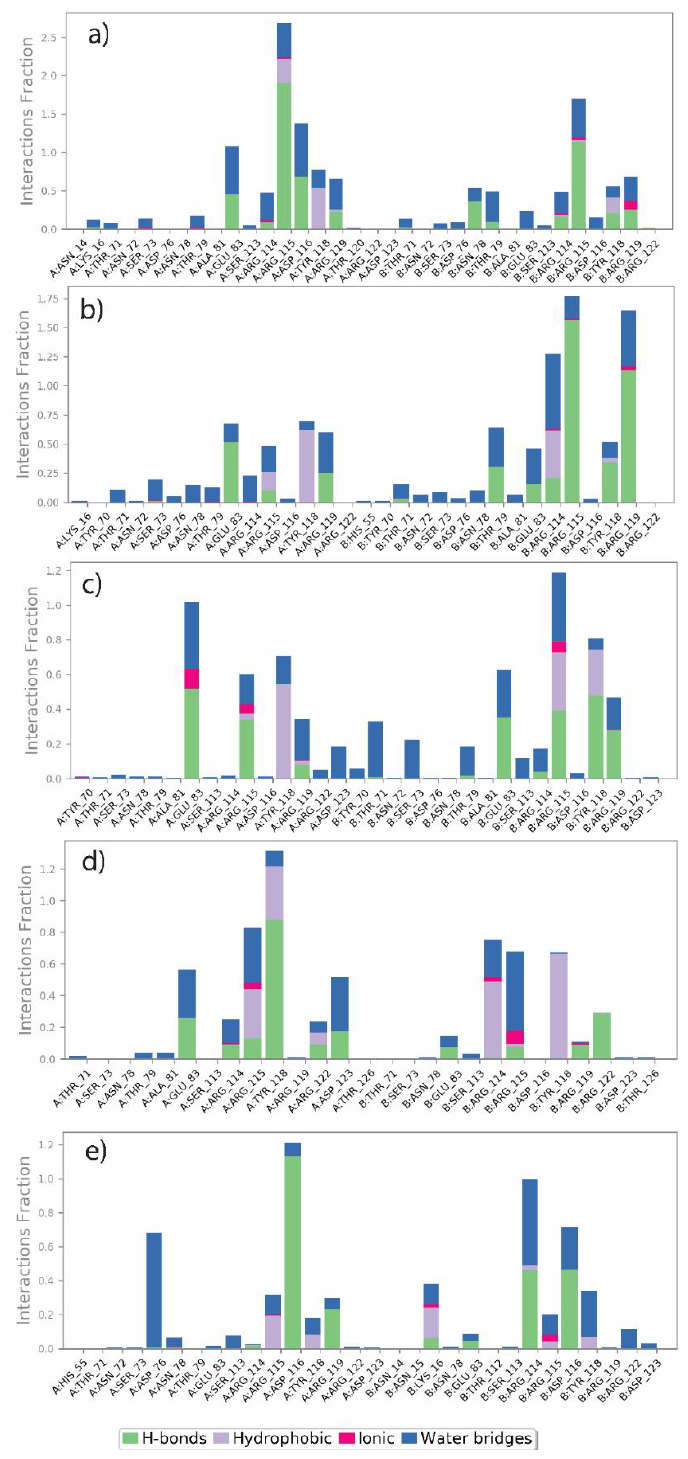
Figure 5. Protein-ligand interactions mapping A42R and selected natural compounds: ( a ) Luteolin 7,3 ′ -diglucuronide, ( b ) Luteolin 7-glucuronide-3 ′ -glucoside, ( c ) Plantagoside, ( d ) Narcissoside, ( e ) (alphaE,8S,9R)-N-(3,4-Dihydroxyphenethyl)-8-[(3,4-dihydroxyphenethyl)carbamoyl]-9-(1,3-benzodioxole-5-yl)-3aalpha,7aalpha-ethano-1,3-benzodioxole-5-acrylamide. Fits on protein were extracted from 100 ns MD simulation trajectories of respective docked complexes.